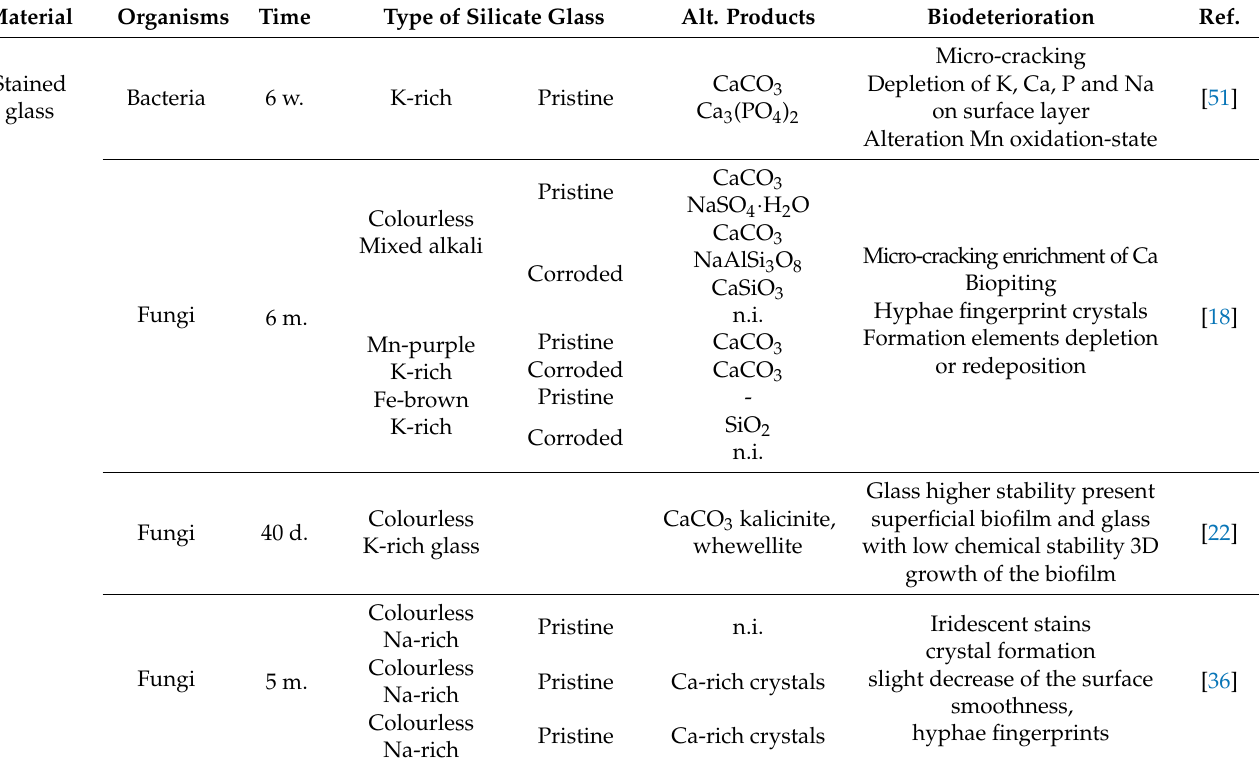
Table 3. Laboratory experiments performed on glass or glaze models to simulate stained glass and glazed tiles biodeteriora- tion. Time in w means weeks, m means months and d stands for days. The alteration products and biodeterioration patterns are also on this table. Alt. Products Biodeterioration